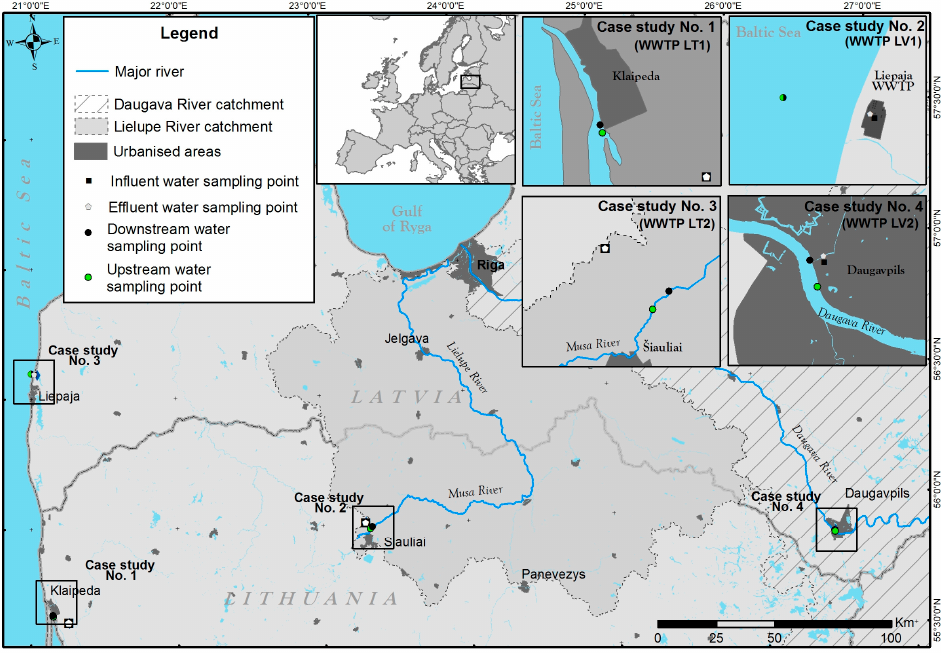
Figure 1. Sampling stations of Latvia and Lithuania.